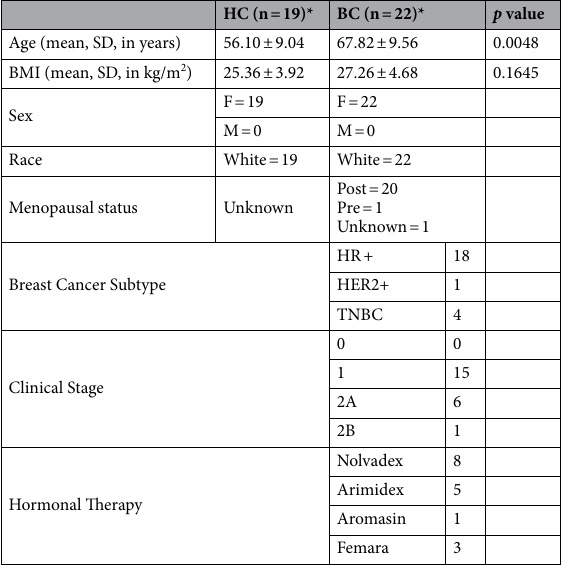
Table 1. Patient and healthy control demographics. *Sample demographics utilized in analysis. HR = hormone receptor, HER2 = human epidermal growth factor receptor 2, TNBC = triple negative breast